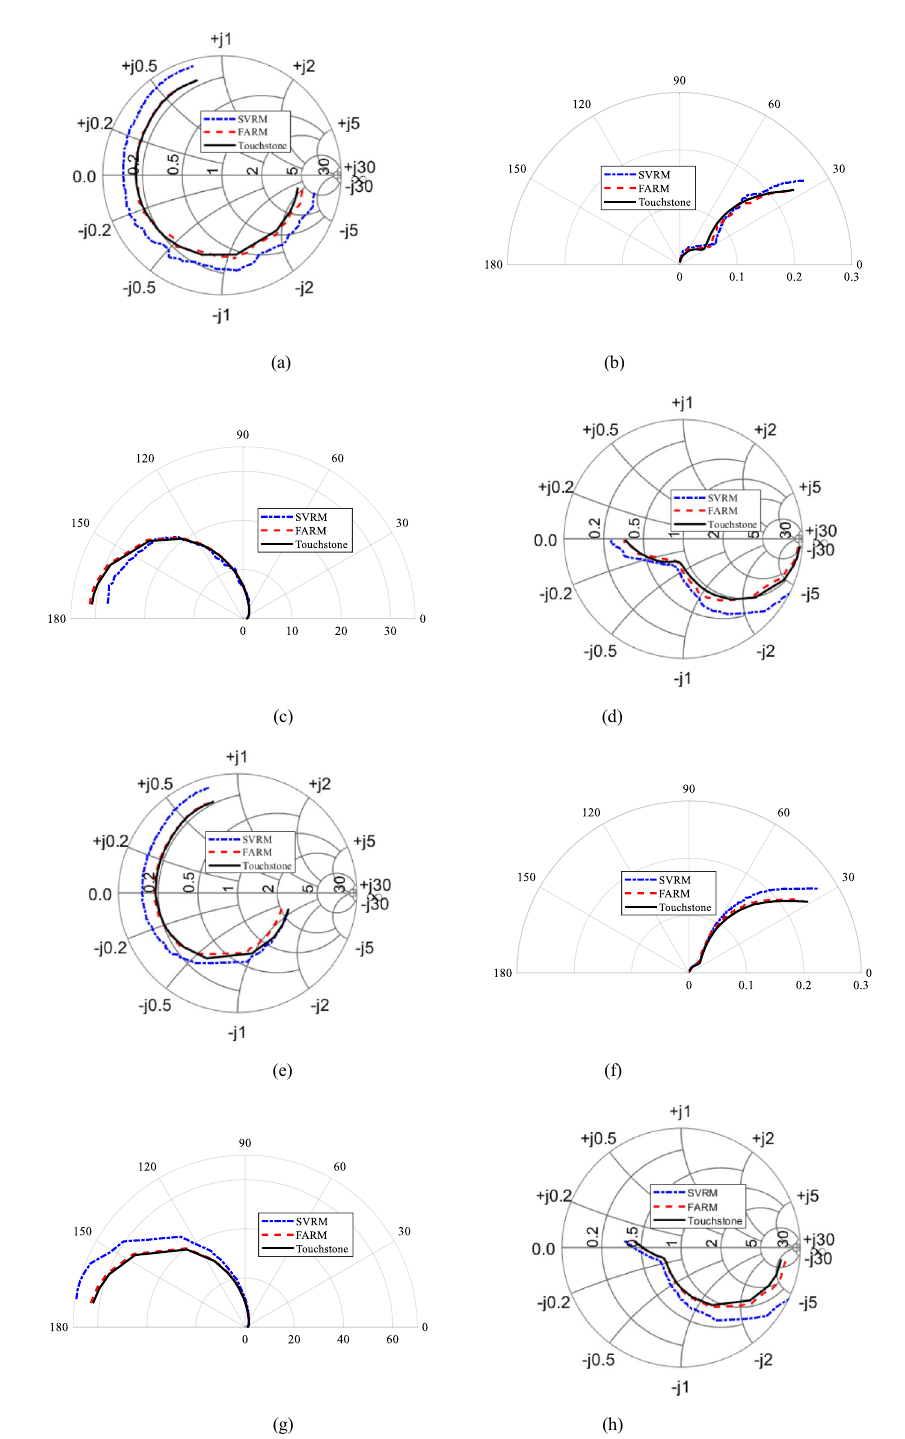
Figure 6. Transistor BFP 193W: Smith chart (for reflection coefficient) and polar graphs (for transmission coefficient) of ( a – d ) S 11 , S 12 S 21 , S 22 at bias voltage V = 2.5 V and bias current I = 12 mA, ( e – h ) S 11 , S 12 S 21 , S 22 at V = 10 V and I = 50